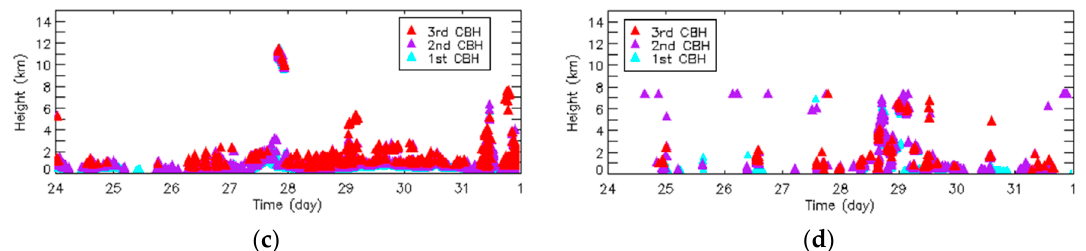
Figure 8. Examples of a summer case on 24–31 July 2019 at ( a , c ) Seoul (Seoul_S2 station), ( b,d ) Taean (Taean_S1 station); ( a , b ) backscatter profiles and ( c , d ) CBHs detected by ceilometer over Seoul. The color bar represents the intensity of backscatter signals. The cyan, purple, and red triangles represent the 1st, 2nd, and 3rd CBHs, respectively.